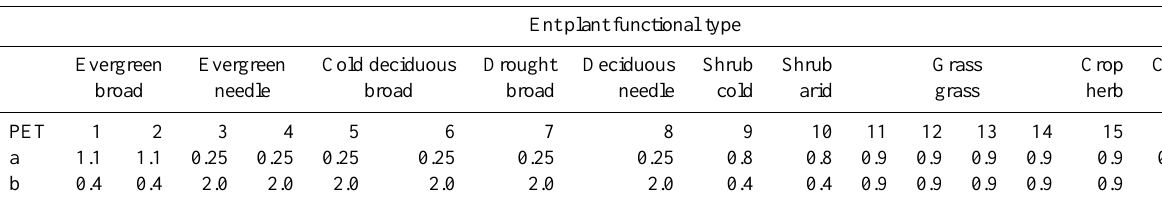
Table A1. Plant functional type parameters for root density distributions.